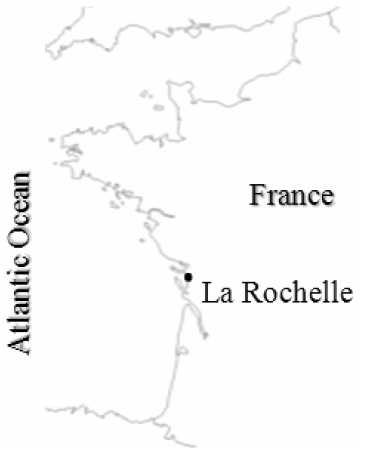
Figure 4. Geographic location of the La Rochelle site.